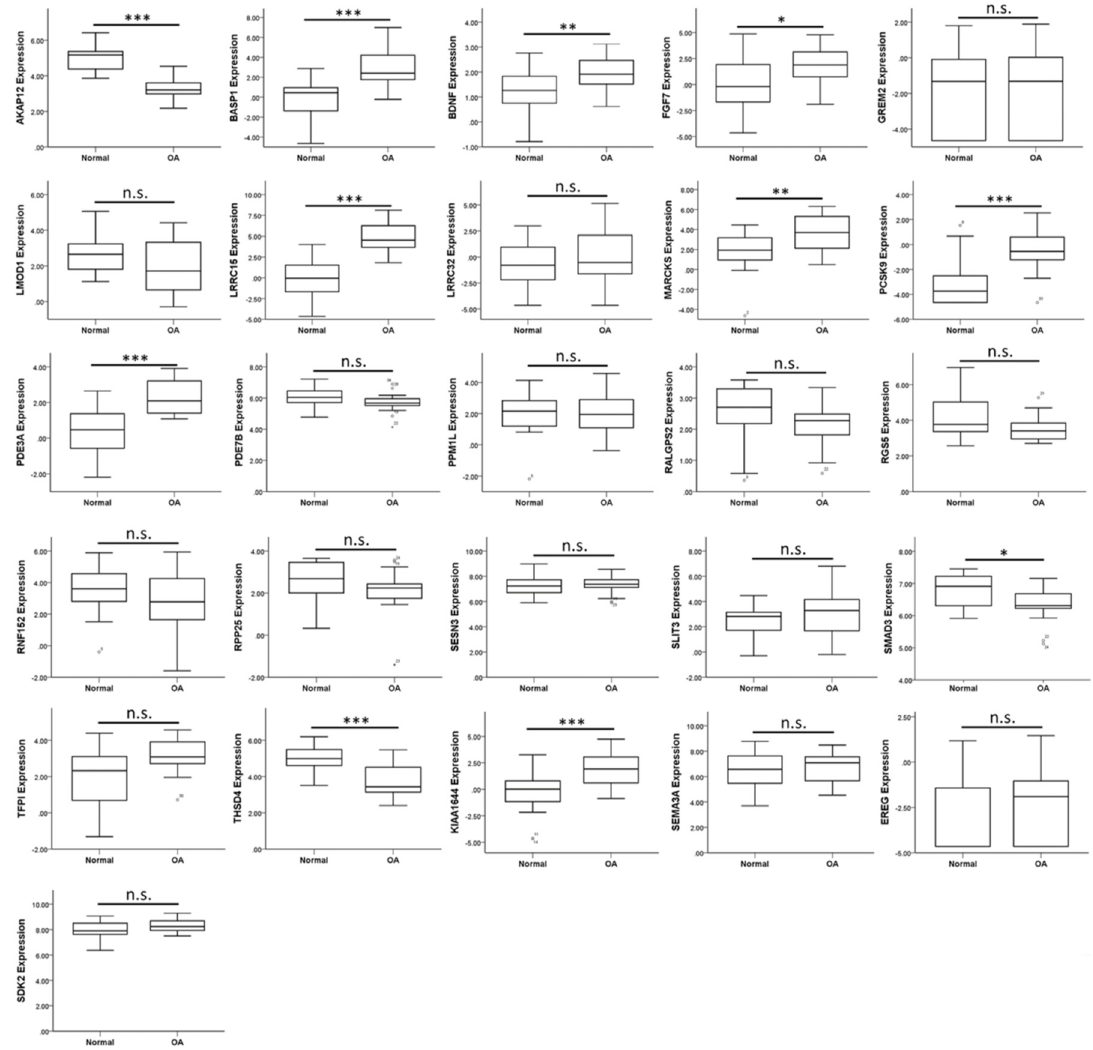
Figure 6. Analysis of 26 candidate genes with potential miRNA–mRNA interactions in the OA-related dataset. The expression values of 22 up-regulated and four down-regulated genes were analyzed in the knee cartilage dataset from GEO database (GSE114007). The significantly up-regulated expression patterns of BASP1 , BDNF , FGF7 , LRRC15 , MARCKS , PCSK9 , and PDE3A in OA knee cartilage were consistent with our OA chondrocytes NGS result. * indicated p < 0.05, ** indicated p < 0.01, *** indicated p < 0.001, and n.s. indicated no statistical significance between normal and OA